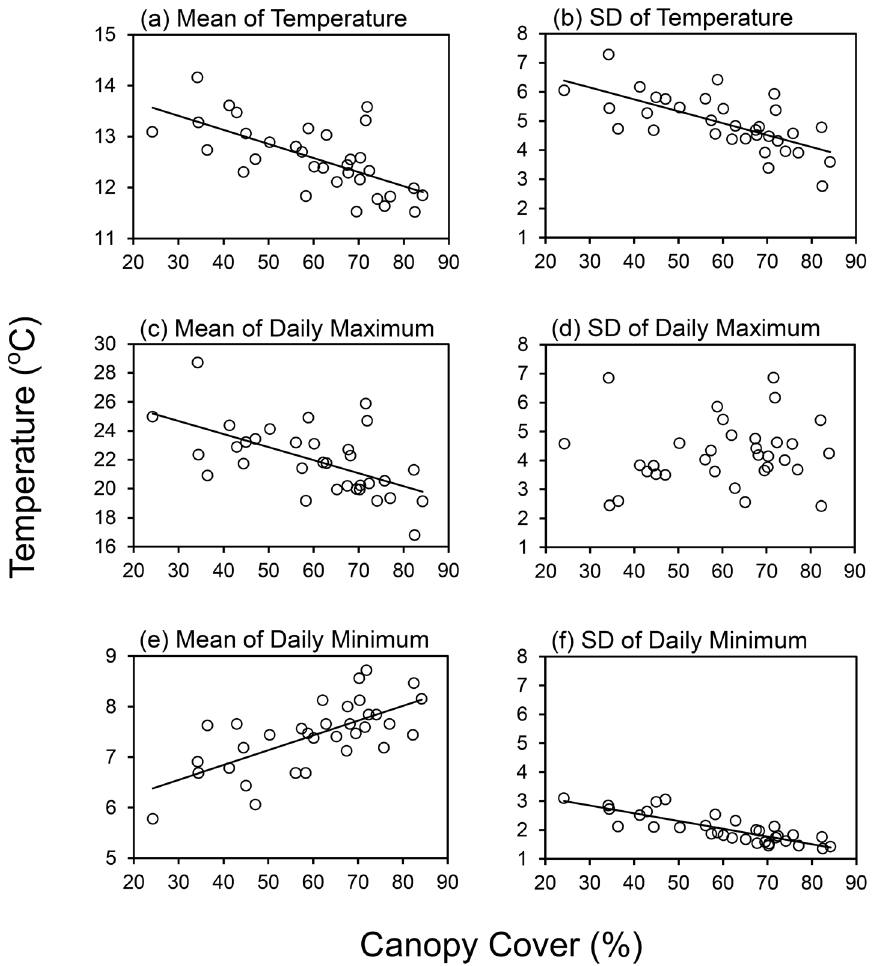
Fig. 3. The relationships between canopy cover and six local temperature parameters for 33 colonies. Solid line of each graph shows the significant model fitted by linear regression. (a) the mean of temperature: y 5 –0.03 x + 14.24, P , 0.001, r 2 5 0.43. (b) the standard deviation (SD) of temperature: y 5 –0.04 x + 7.38, P , 0.001, r 2 5 0.46. (c) the mean of daily maximum temperature: y 5 –0.09 x + 27.39, P , 0.001, r 2 5 0.34. (d) the SD of daily maximum temperature: not significant. (e) the mean of daily minimum temperature: y 5 0.03 x + 5.67, P , 0.001, r 2 5 0.46. (f) the SD of daily minimum temperature: y 5 –0.03 x + 3.66, P , 0.001, r 2 5 0.69.